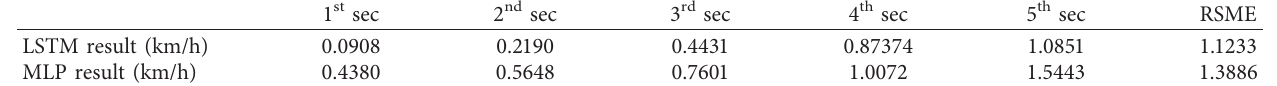
Table 1: Average error per second and RSME of the prediction results.